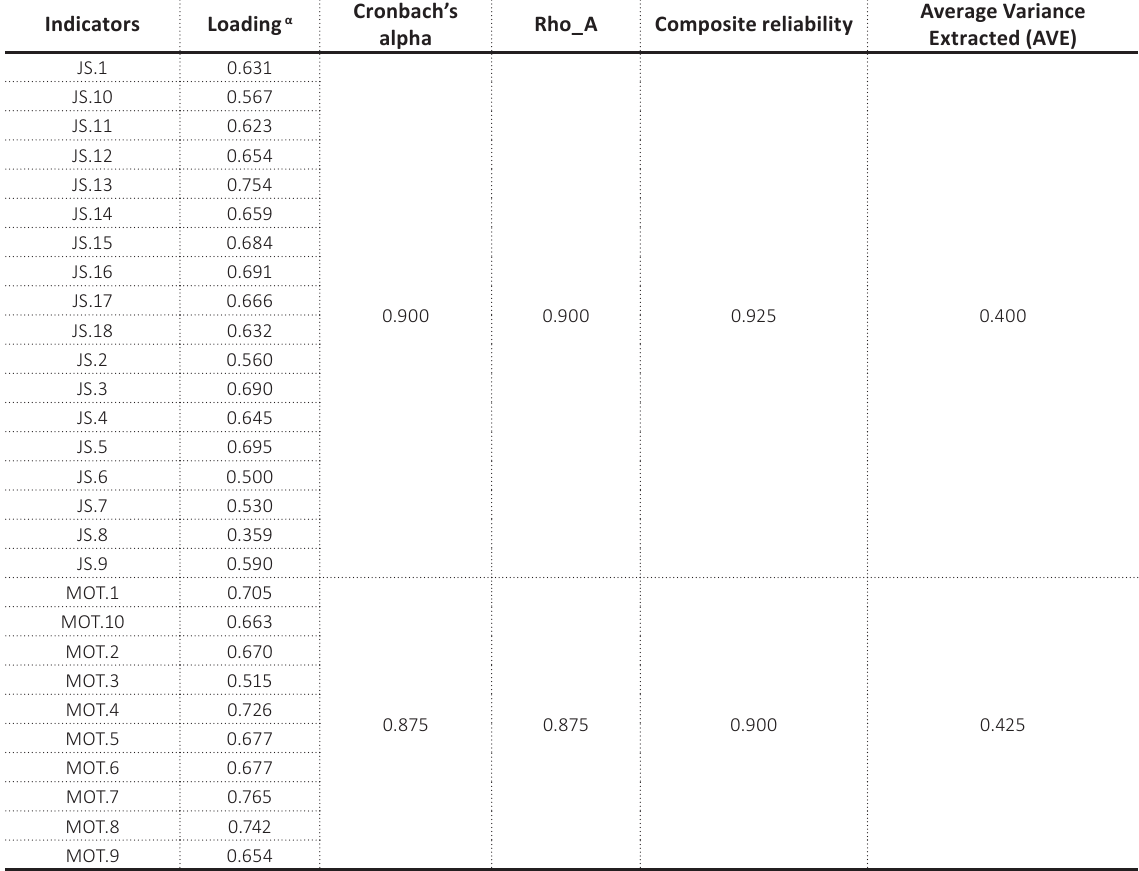
Table 2 (cont.). Factor loading and reliability